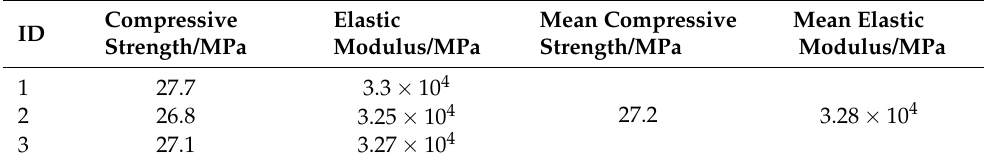
Table 3. Properties of the concrete.